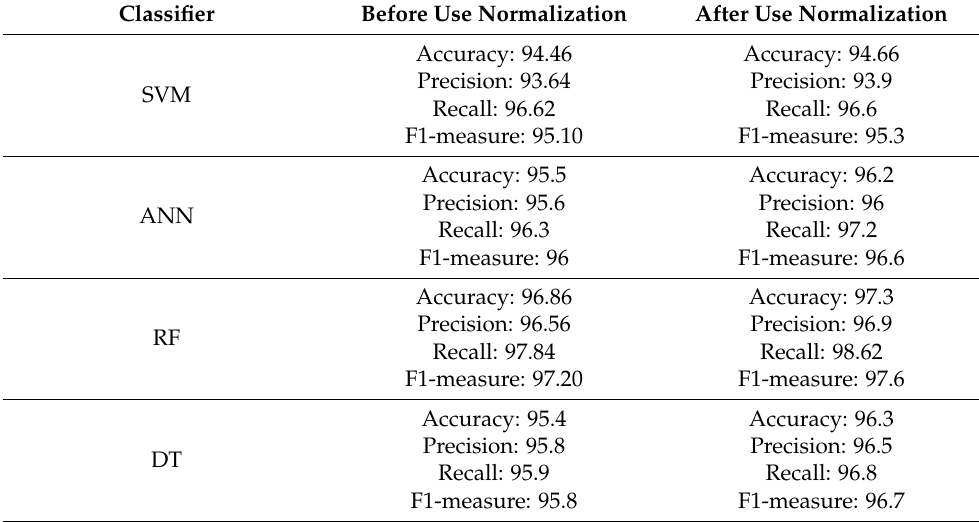
Table 2. The performance results before and after using the normalization